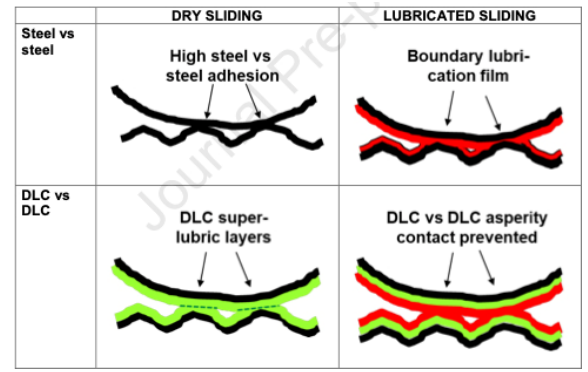
Fig. 34 Illustrative differences between steel vs steel and DCL coated vs DLC contacts under dry and lubricated sliding conditions [536]. Reproduced with permission from Ref. [536], © Elsevier B.V.,